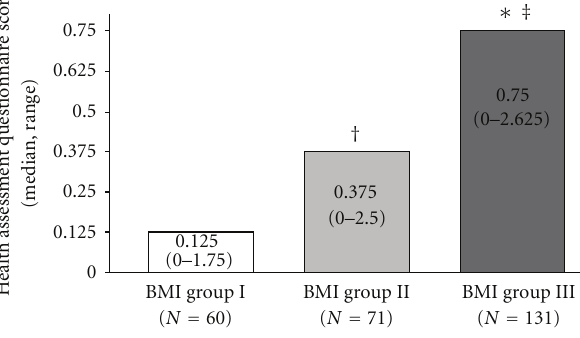
Figure 1: Health Assessment Questionnaire (HAQ) scores (median, range) across the three body mass index (BMI) study groups (Group I: 35–39.99 kg/m 2 ; Group II: 40–44.99 kg/m 2 ; Group III: ≥ 45.0 kg/m 2 ). ∗ Group III versus Group I ( P < 0 . 001); ‡ Group